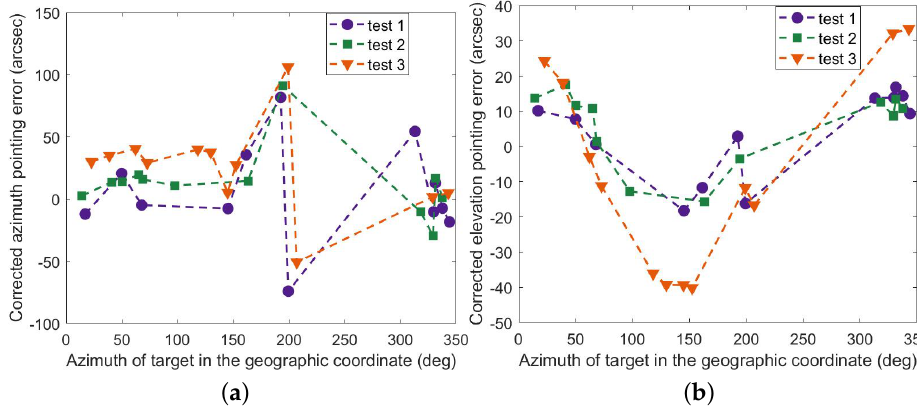
Figure 14. Residual errors of MM ( a ) in azimuth and ( b ) in